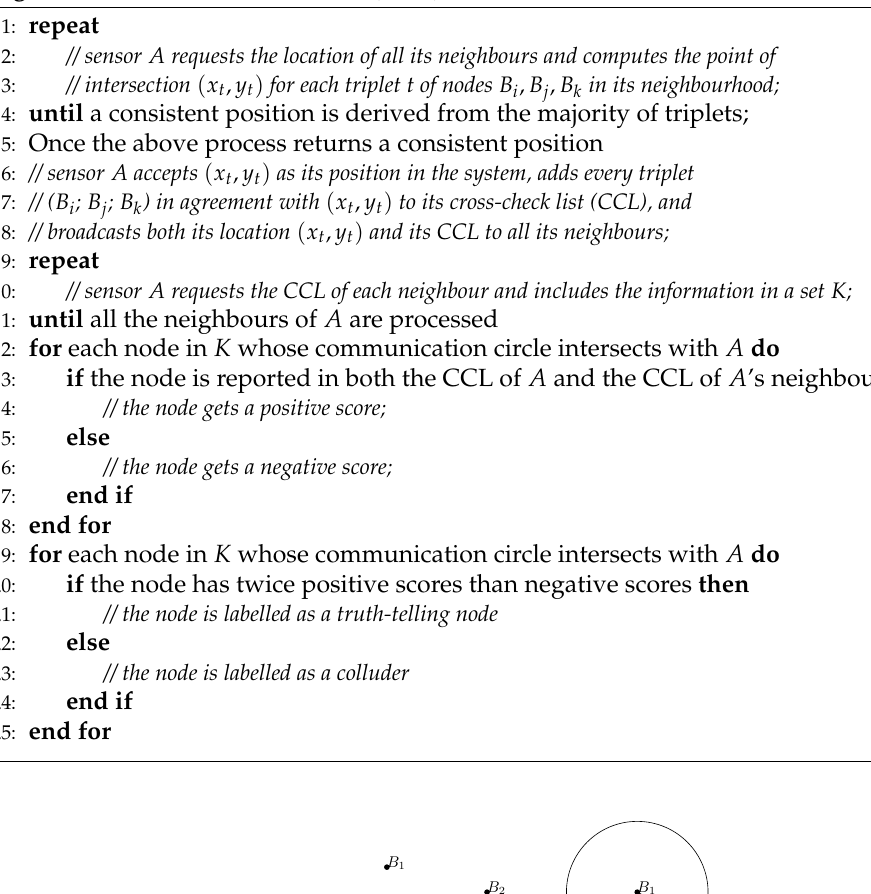
Algorithm 1 S UPER CROSS - CHECK (SCC)